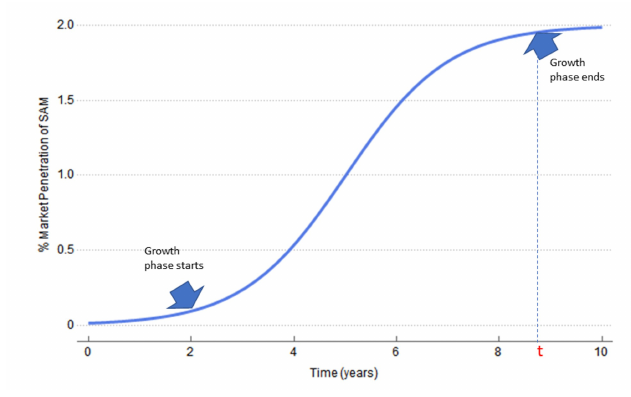
Figure 2: Evolution of Network towards